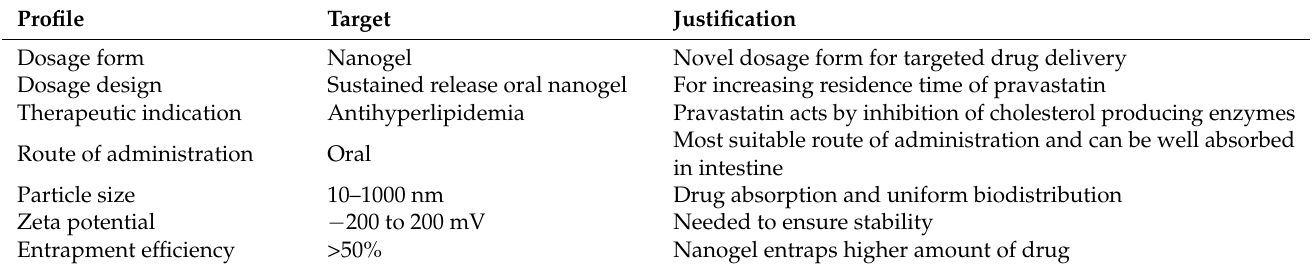
Table 7. Quality by Design (QbD)